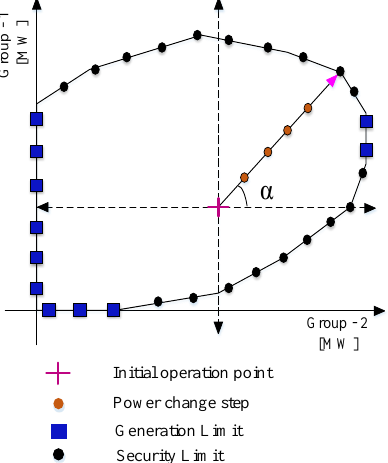
Figure 2. Security region nomogram.